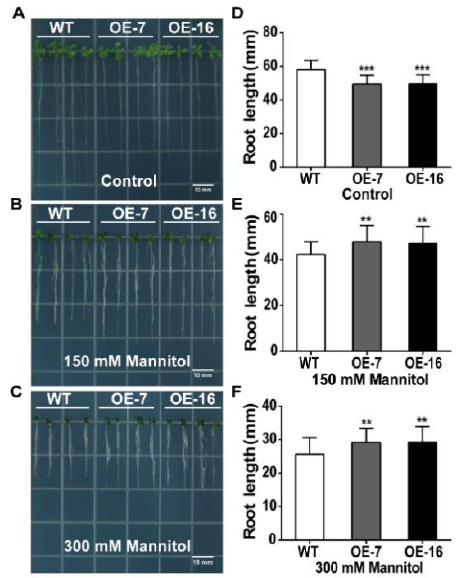
Figure 7. Osmotic tolerance of TaWRKY46 -overexpressing Arabidopsis plants. ( A – C ) The phenotype of seedlings after treatments with 0 mM, 150 mM, and 300 mM mannitol for 10 days. ( D – F ) The root length statistics of seedlings after treatments with 0 mM,150 mM, and 300 mM mannitol for 10 days. Asterisks indicate a significant difference between WT and transgenic Arabidopsis lines (** p < 0.01; *** p < 0.001). Scale bar = 10 mm.